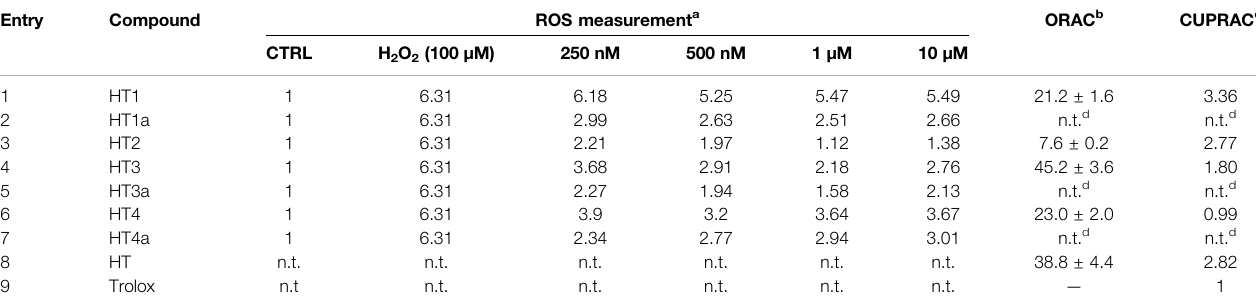
TABLE 2 | Antioxidant activity of donepezil hybrids: effects of donepezil hybrids against ROS production induced by H 2 O 2 in SH-SY5Y cell cultures; ORAC and CUPRAC assay. Entry Compound ROS measurement a ORAC